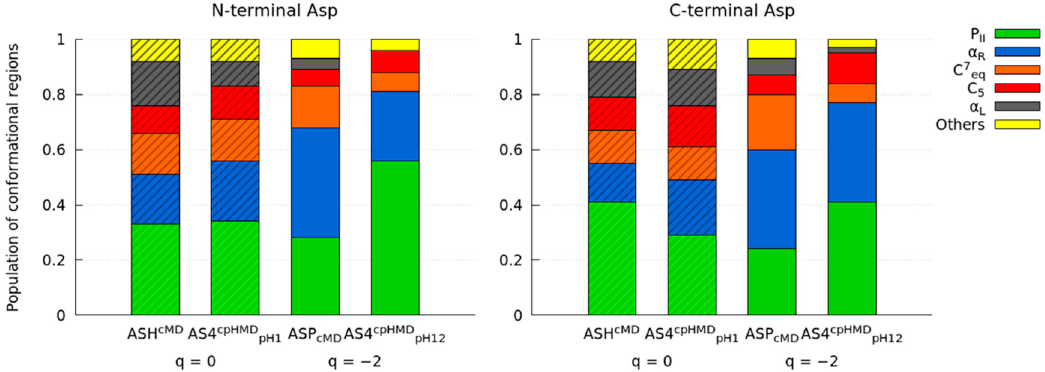
Figure 3. Populations of the conformational regions (P II , α R , C 7 eq , C 5, and α L ) in the Ramachandran maps of each amino acid of the capped Asp 2 tripeptide. Labels indicate the residues, the simulation method in the superscripts, and the pH value in the subscripts. Net charge of the tripeptide was below (q). Striped or solid box style are protonated or deprotonated states, respectively.